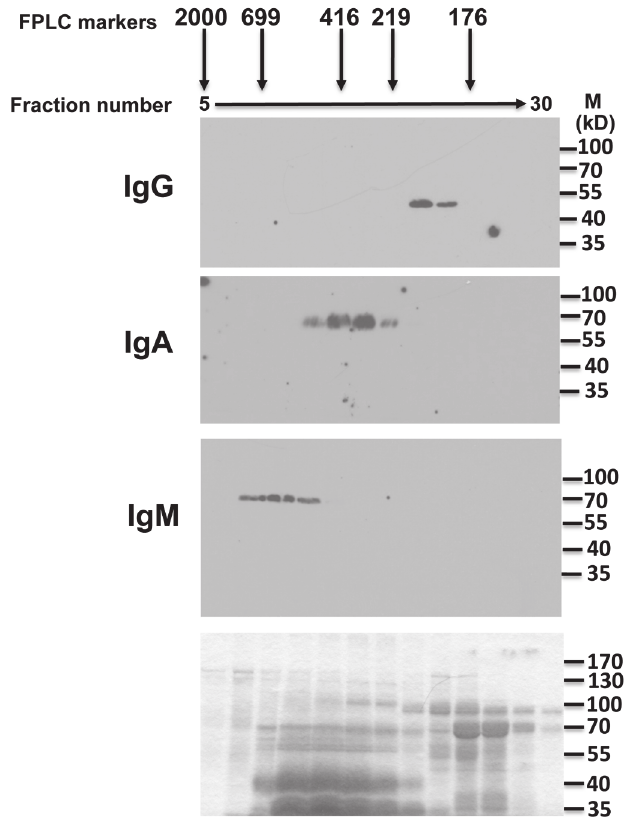
Fig 3. Immunoblot analysis of Asian elephant milk following fractionation by gel filtration. Liquid fractions eluting off from gel filtration of Asian elephant milk were resolved and analyzed by immunoblotting. Fraction numbers are labeled at the top and the approximate sizes of marker proteins are indicated. Three identical gels were then probed with isotype specific antisera or monoclonal antibody (anti-IgG) as indicated to the left of each blot. The bottom panel is a coomassie stained gel identical to the gels used for the Westerns above. Molecular weight markers for the blots are shown on the right of each panel.